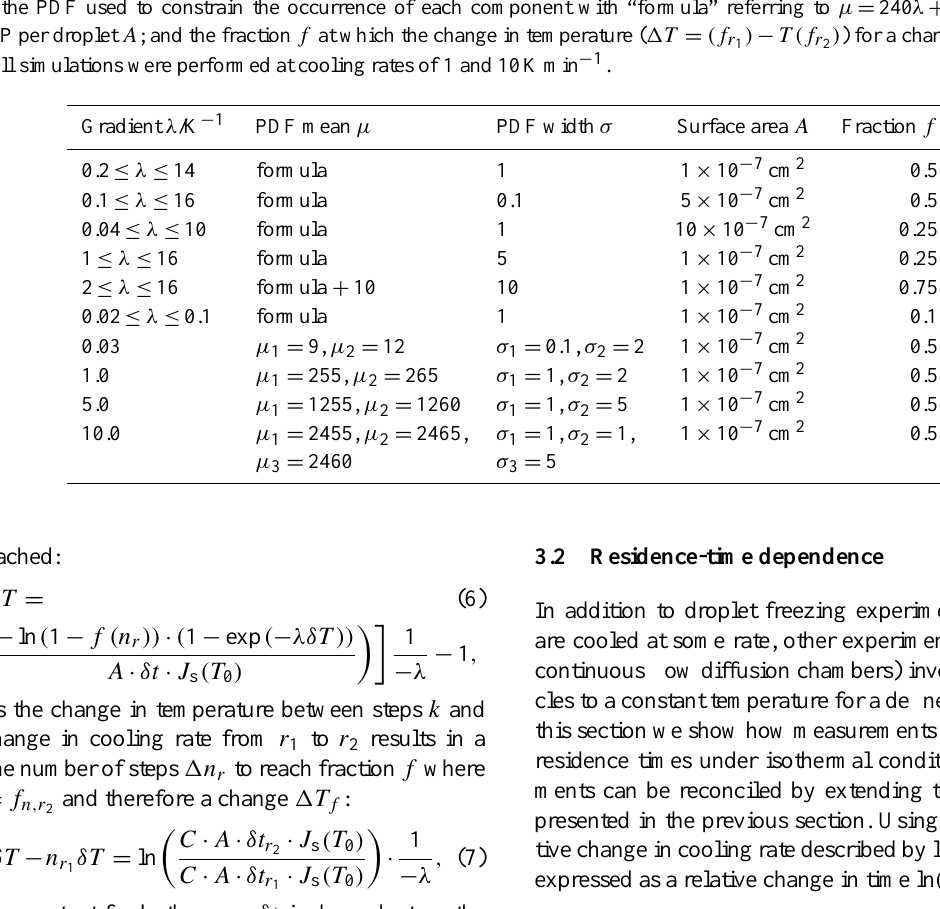
) − T (f r ) ) for a change in cooling rate r is 1 2